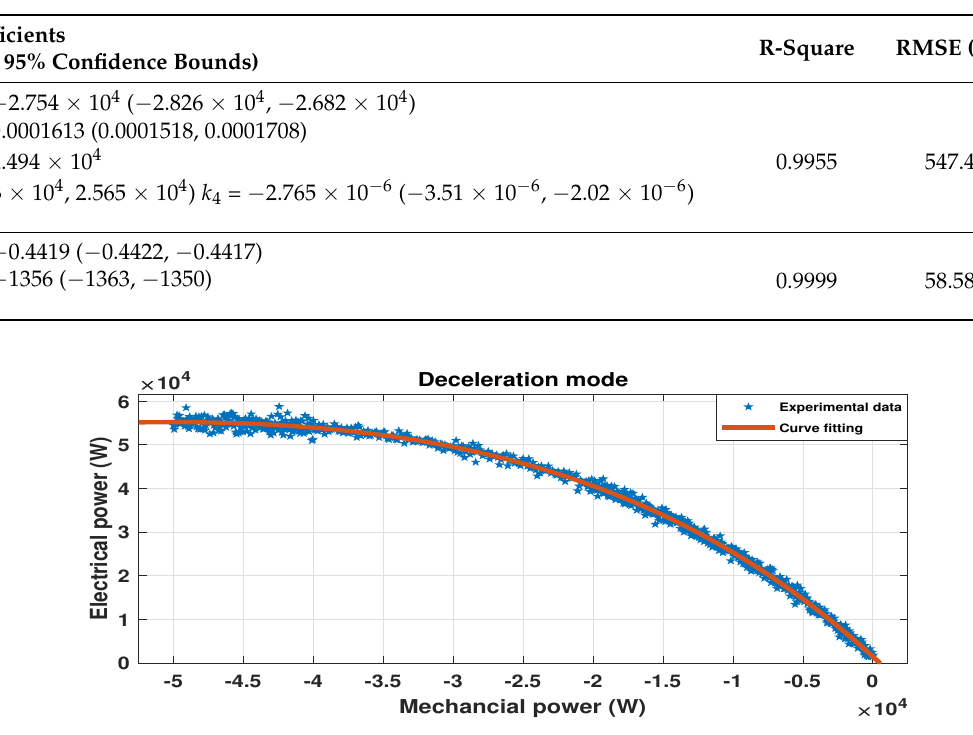
Figure 12. Battery power as a function of mechanical power in deceleration mode with braking.